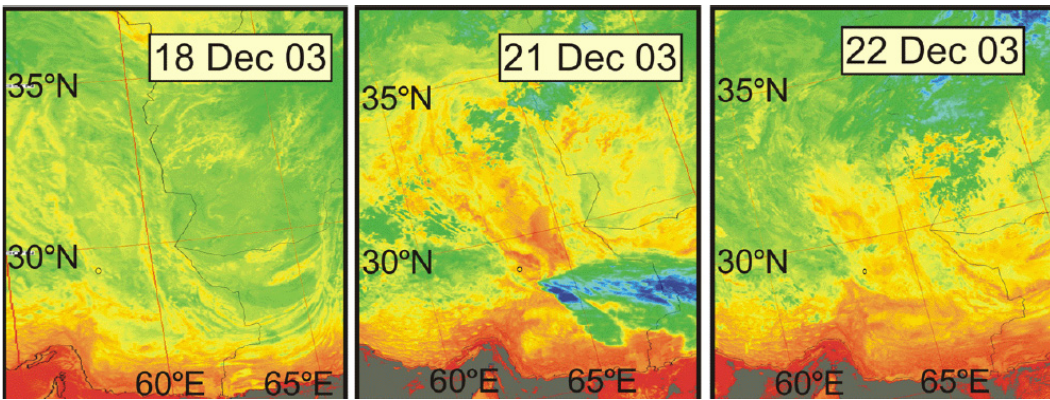
Figure 15. Thermal anomalies associated with the Bam earthquake (M = 6.6, 26 December 2003, Iran). NOAA-AVHRR nighttime data, the star indicates the earthquake epicenter